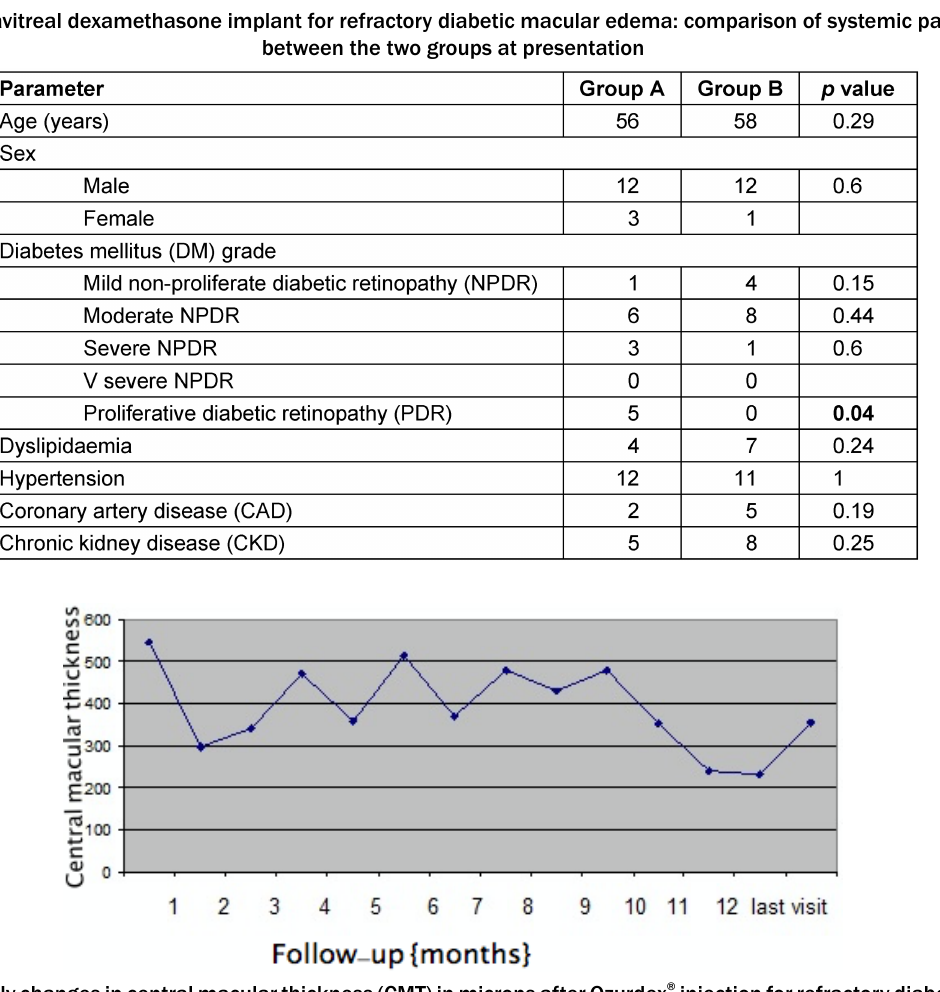
Figure 2: Monthly changes in central macular thickness (CMT) in microns after Ozurdex ® injection for refractory diabetic macular edema in 28